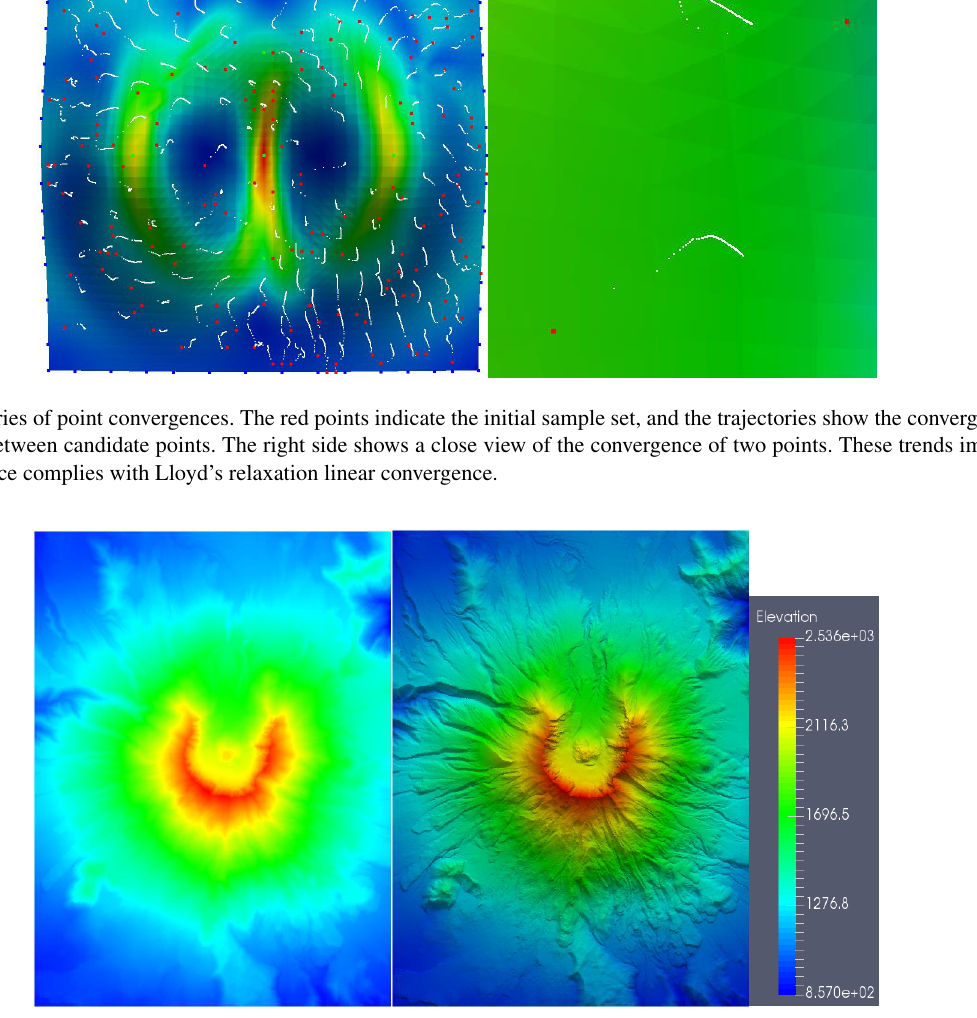
Figure 10. Experimental site 1: Mount St. Helens. Left: image view. Middle: hillshade view. It is a 2924 × 3894 grid with a 3m cell